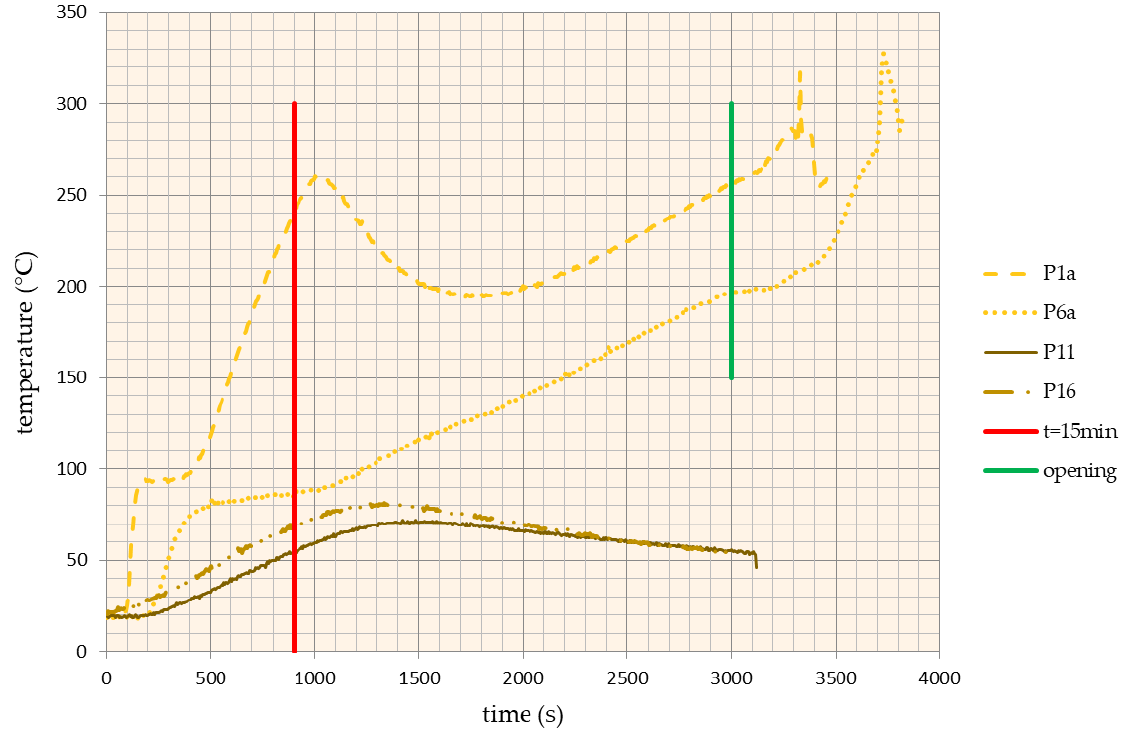
Figure 8. Summary of temperature trends in time for specimens (P1a, P6a, P11, P16) measured at a depth of 50.0 mm (data from own research).